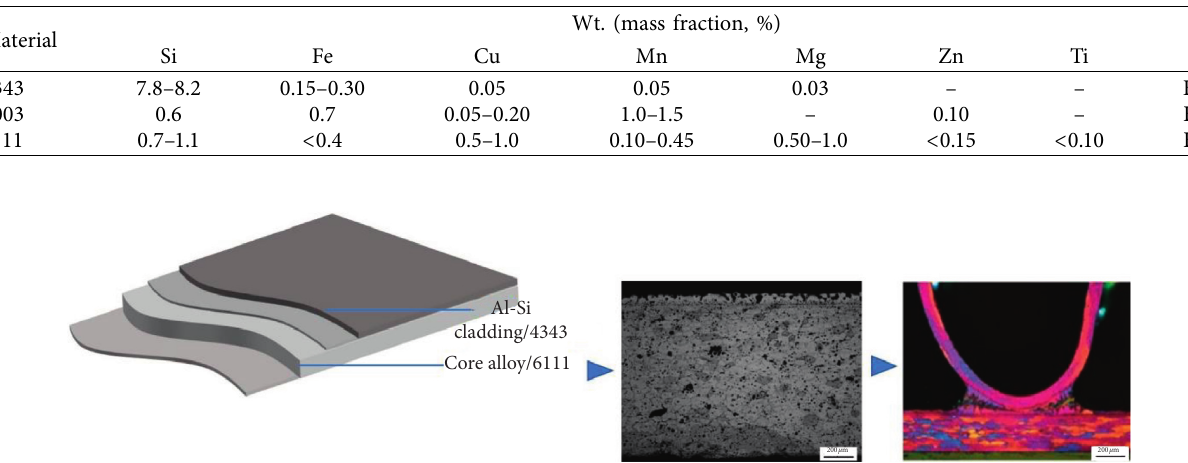
Figure 1: Brazing process of aluminum clad sheets with Al-Mg-Si core alloy and Al-Si clad layers.